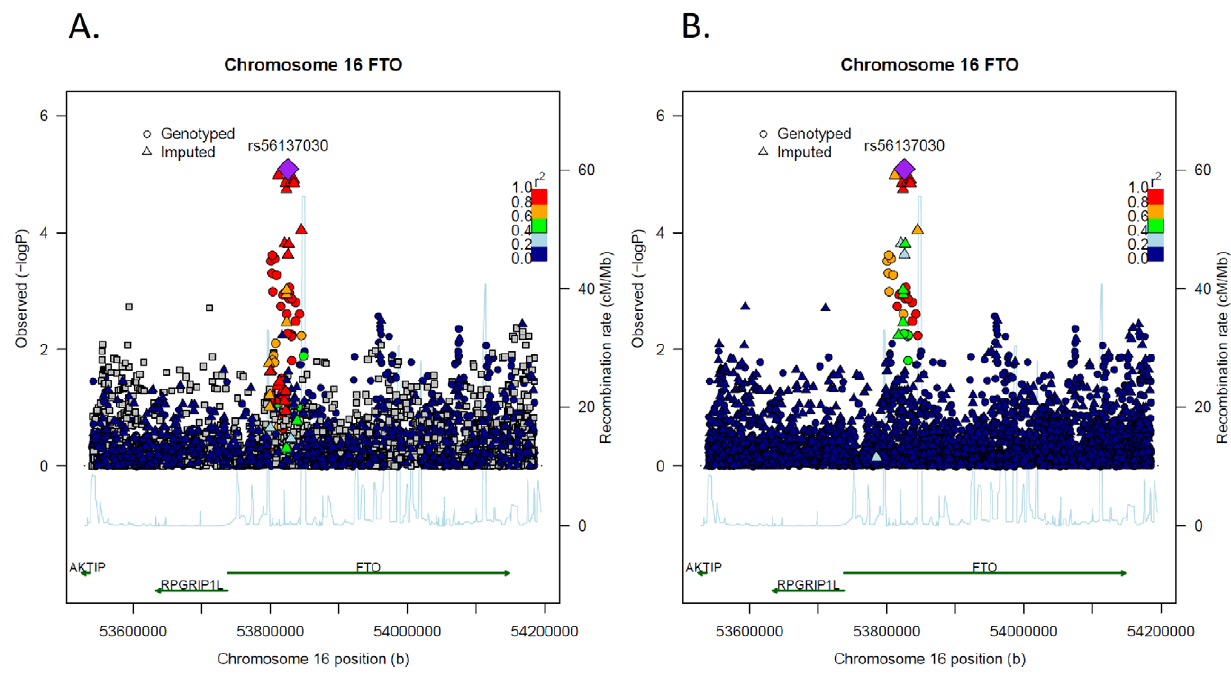
Figure 1. Association results (p-values) and correlation structure for all SNPs in the 16q12.2/ FTO region and lnBMI among African Americans using rs56137030 to calculate correlation among SNPs (LocusZoom plots). The top half of each figure has physical position along the x axis, and the 2 log 10 of the meta-analysis p-value on the y-axis. Each dot on the plot represents the p-value of the association for one SNP with lnBMI across all studies. The most significant SNP (rs56137030) is marked as a purple diamond. The color scheme represents the pairwise correlation (r 2 ) for the SNPs across the 16q12.2/ FTO region with the most significant SNP (rs56137030). Gray squares indicate that correlation was missing for this p-value because the variant was monomorphic in EA. The bottom half of the figure shows the position of the genes across the region. A and B show the same region and results. The only difference between A and B is that in A correlation with the most significant SNP (rs56137030) was calculated based on EAs, specifically based on data from 65 European Americans (Utah residents with Northern and Western European ancestry from the CEPH collection, CEU) sequenced as part of the 1000 Genomes Project and B correlation was based on 61 African Americans from the South- west (ASW) and sequenced as part of the 1000 Genomes Project.